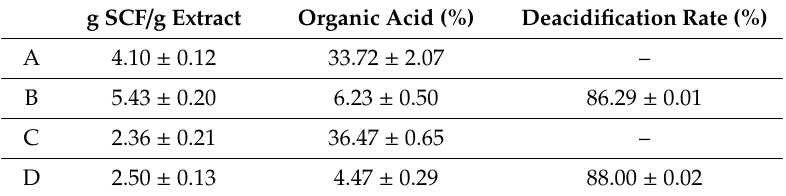
Table 1. Organic acid content determination of sample A, B, C, and D. SCF: Schisandra chinensis Fructus